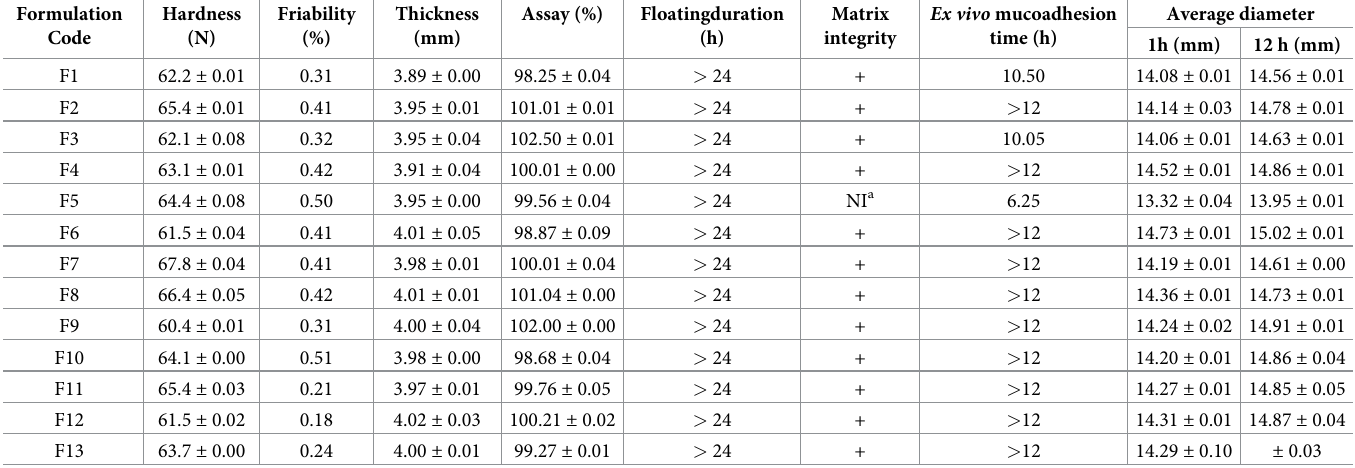
Table 3. Characteristic properties of floating, bioadhesive and swelling sustained release matrix tablets of ranitidine HCl (150). Formulation Code